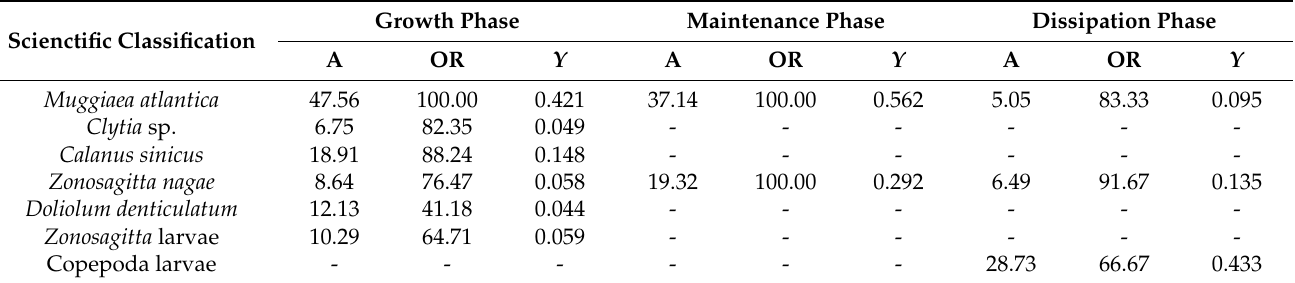
Table 1. The average abundance (A, ind. m − 3 ), occurrence ratio (OR, %), and dominance ( Y ) of dominant species during the P. donghaiense